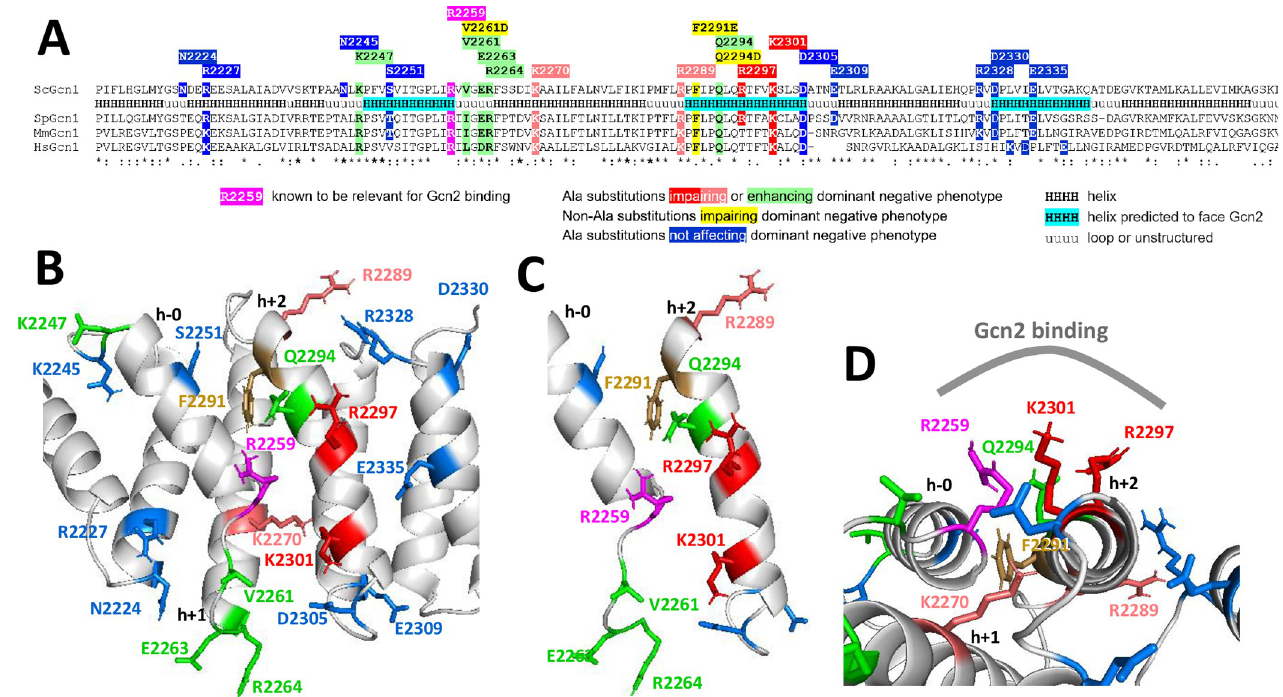
Fig 6. Location of substituted amino acids in Gcn1. (A) Multiple sequence alignment of Gcn1. Gcn1 proteins from Saccharomyces cerevisiae , Schizosaccharomyces pombe , Mus musculus , and Homo sapiens (accession numbers P33892, Q10105, AAI50736.1, NP_006827.1) were subjected to a multiple sequence alignment using Clustal omega [31]. A portion of the alignment covering the area surrounding yeast Gcn1 Arg-2250 is shown. Beneath the S . cerevisiae Gcn1 sequence its secondary structure is shown as modelled by [20]. Helixes predicted to face Gcn2 are highlighted in cyan. Amino acid substitutions investigated in this work are highlighted and the key for the colours is provided in the image. (B) Shown is a portion of the modelled structure of the S . cerevisiae RWDBD [20], and amino acids investigated are highlighted as in (A). (C) Same image as in (B), just that only the helix adjacent to Arg-2259 (dubbed h-0) and the neighbouring helix (h+2) harbouring Arg-2289, Arg-2297 and Lys-2301 are shown. (D) Side view of the helices h-0 and h+2, and the potential Gcn2 interaction side. Part of helix h+1 can be seen which connects helix h-0 with helix